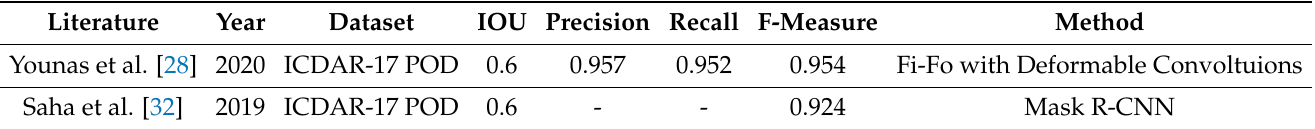
Table 5. Formula detection performance